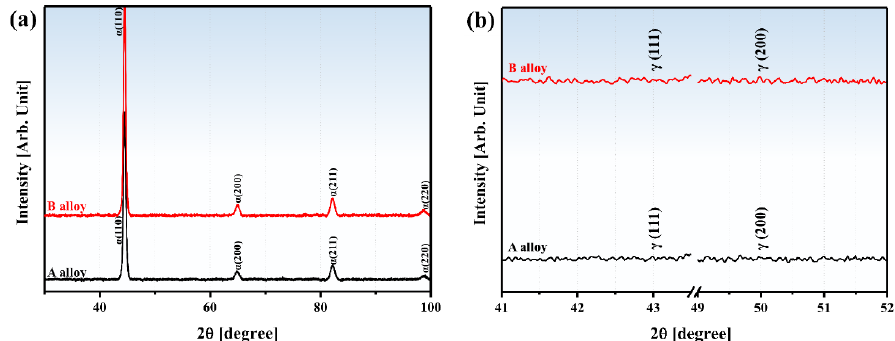
Figure 3. ( a ) XRD spectra of direct-quenched steels: alloy A (black line) and alloy B (red line); ( b ) XRD intensities of γ (43.28° (111) and 50.40° (220)) peaks.